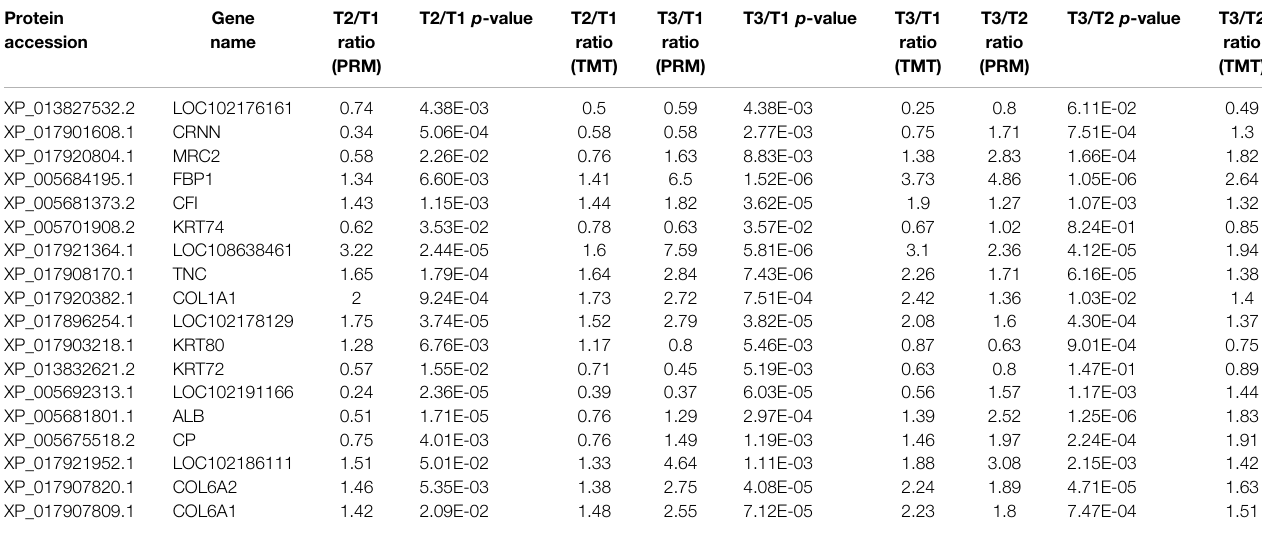
TABLE 1 | PRM result compared with TMT-based quantitative result. Protein